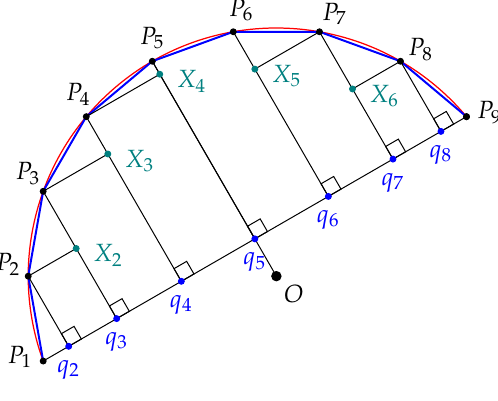
Figure 8. Inscribed length estimates for an odd number of points on an arc.